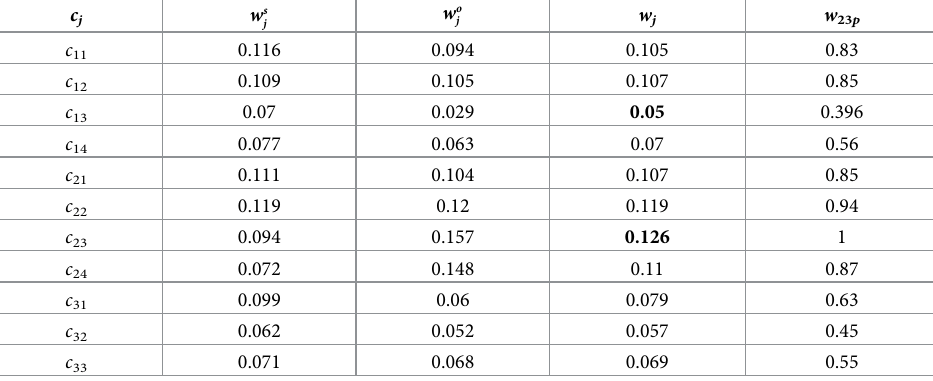
Table 10. Subjective weight, objective weight, comprehensive weight and relative weight of sub-criteria c j . w o c j w s j w j j